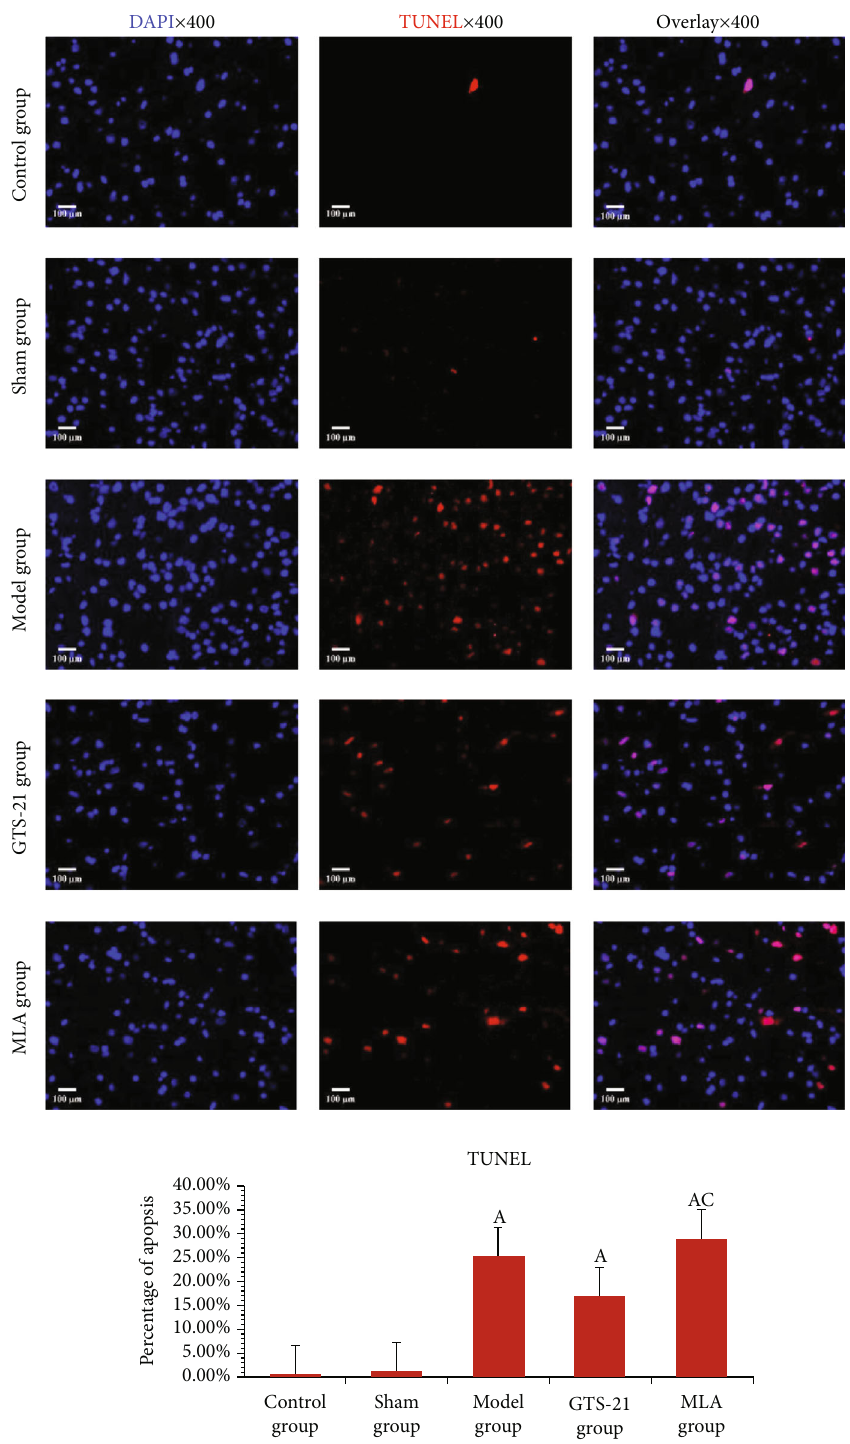
Figure 5: Cell apoptosis in MVZ among di ff erent groups. The results of TUNEL show that much more apoptotic percentages occurred in the sepsis groups (including the model group, GTS-21 group, and MLA group) than in the control group. The P value and 95% CI were, respectively, 0.000, -0.337 ~ -0.160; 0.000, -0.253 ~ -0.077; and 0.000, -0.374 ~ -0.197. GTS-21 decreased the apoptotic percentage when compared with the model group (0.074, -0.00 ~ 0.172). MLA signi fi cantly increased the apoptotic percentage when compared to the GTS- 21 group; it reached a signi fi cant di ff erence (the P value and 95% CI were, respectively, 0.003 and -0.209 ~ -0.032). The scale bars at the bottom left of the images represent 100 μ m. a: P < 0 : 05 vs. control group; c: P < 0 : 05 vs. GTS-21